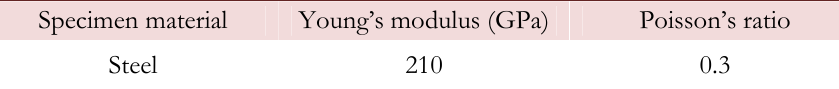
Table 1: Material properties.